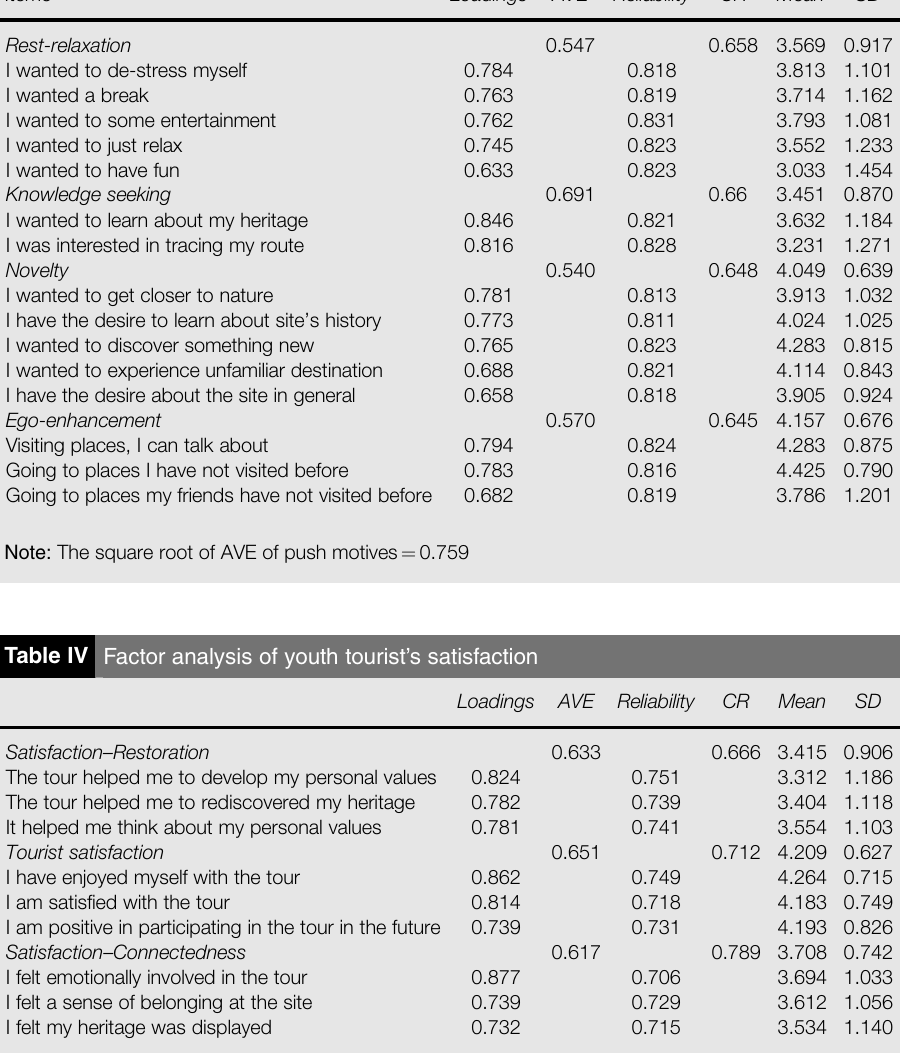
Table III Factor analysis of push motives of youth tourism